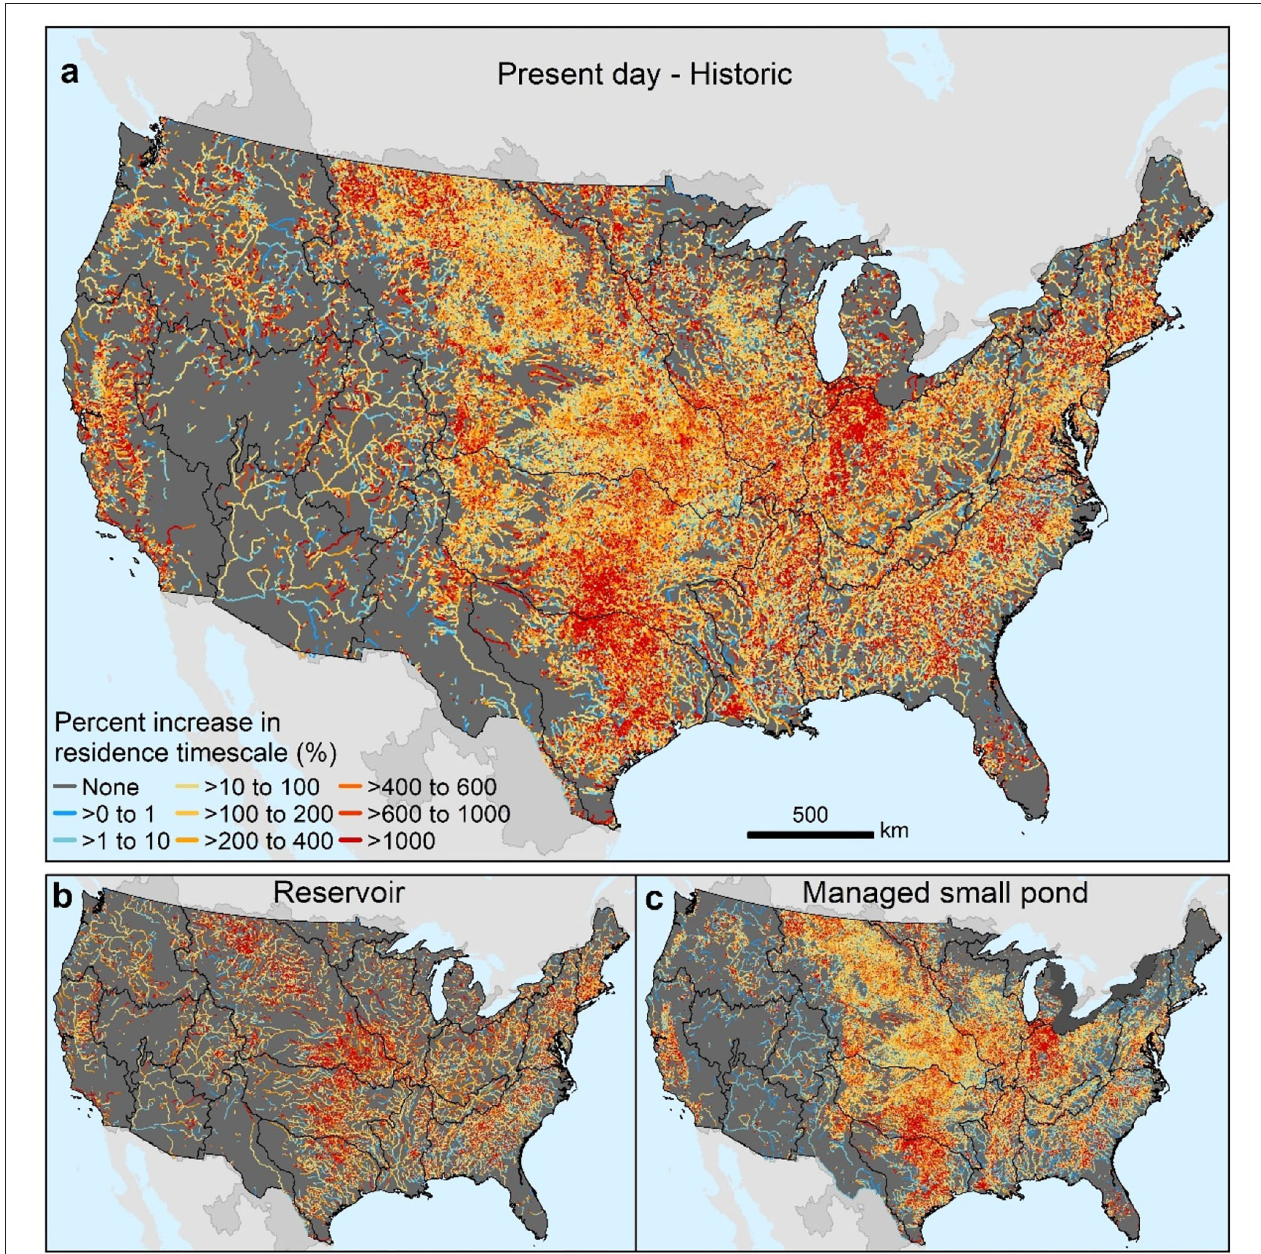
FIGURE 6 | Estimated change, in percent, in river corridor water residence timescale during the twentieth century (a) and estimated twentieth century change in reservoir and managed small pond water residence timescale associated with construction of reservoirs and management of small ponds (b,c) . Black boundaries designate HUC-2 river